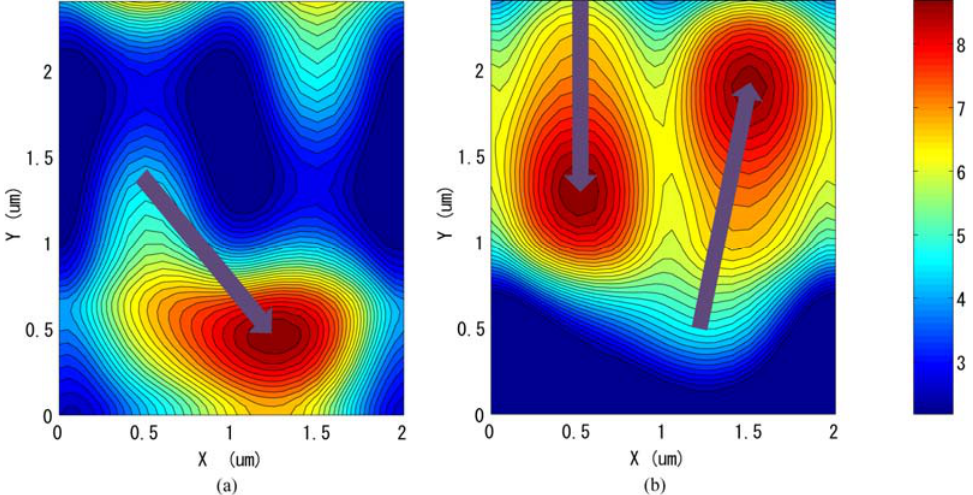
Figure 7. Channel potential profile at a fold of a two-phase transfer ISAS. Each memory element has a size of . Arrows indicate the proposed reverse transfer direction along the